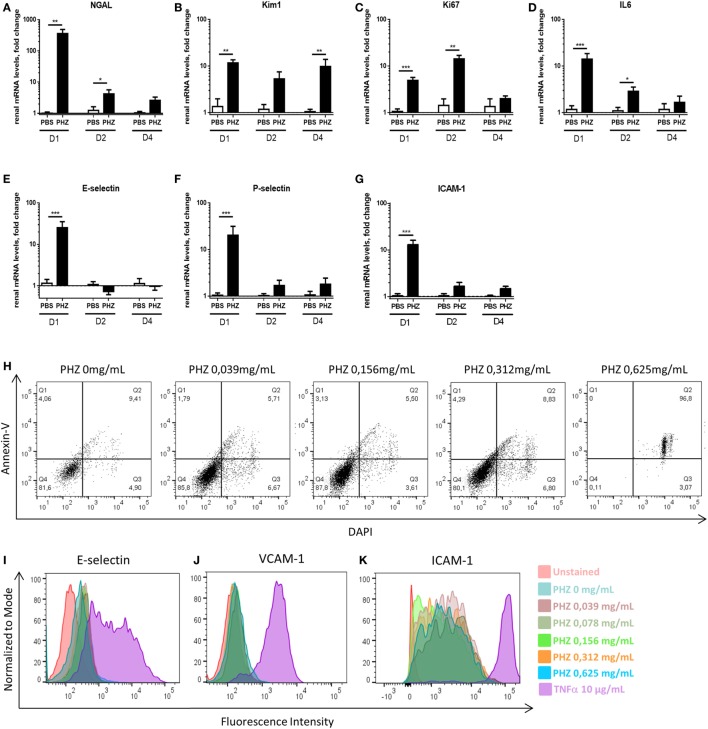
Hemolysis inducing renal injury. Kinetics of mRNA levels in renal tissue of (A) NGAL, (B) Kim-1, (C) Ki-67, (D) IL-6, (E) E-selectin, (F) P-selectin and (G) ICAM-1 at 1, 2, and 4 days after PBS or phenylhydrazine (PHZ) injection. (H) Human umbilical vein endothelial cells (HUVECs) were incubated for 24 h with increased concentration of PHZ in M199 medium, containing 20% fetal calf serum, and cell death was measured by double staining with annexin-V and DAPI by flow cytometry. (I–K) HUVECs were incubated for 24 h with increased concentration of PHZ or TNF-α as a positive control, in M199 medium, containing 20% fetal calf serum. E-selectin (I), VCAM-1 (J), and ICAM-1 (K) were measured by flow cytometry. Data are presented for 0.312-mg/mL PHZ, gating on live (annexin-V−, DAPI− cells, about 80% of the total cell population). Mean ± SEM, * p < 0.05, ** p < 0.005, *** p < 0.001, and Mann–Whitney test.